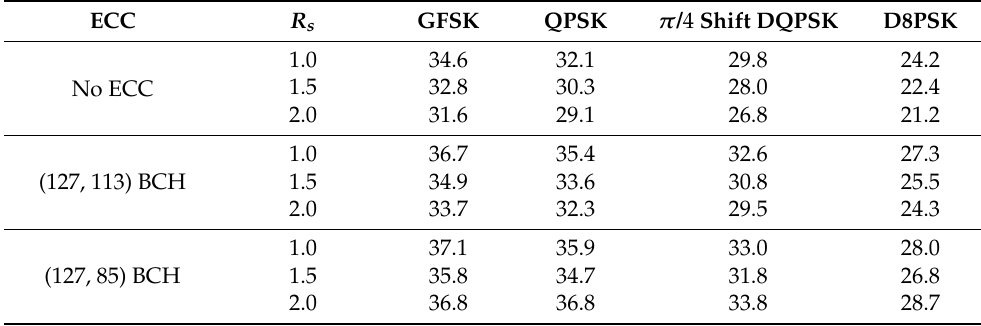
Table 12. Examples of fade margins (dBm). PER ≤ 10 − 2 , L PSDU = 127 bytes, NF dB = 13 dB and I dB = 6 dB.